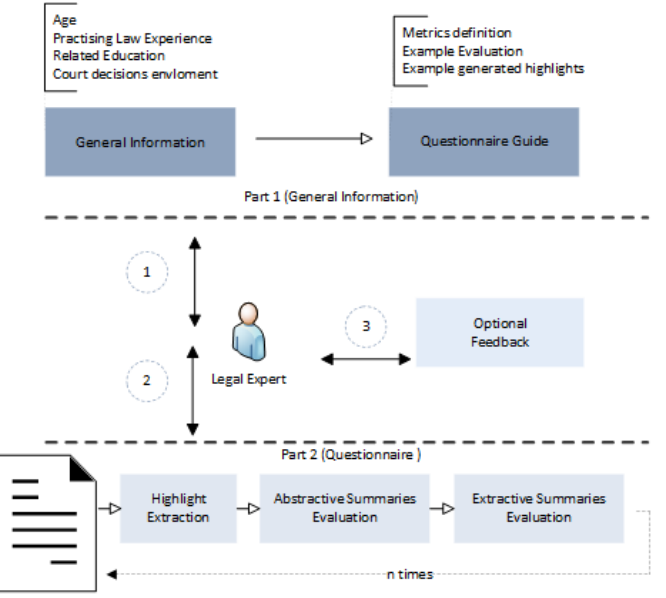
Figure 8. A flowchart schema of the survey page web interface. Each participant is firstly asked to answer questions related to general information about him/her and then presented with a guide that explains the questionnaire question’s format and how to answer each question. Afterwards, the participant iteratively evaluates the extractive and abstractive summaries of the judicial judgment texts. Additional feedback may be provided at the